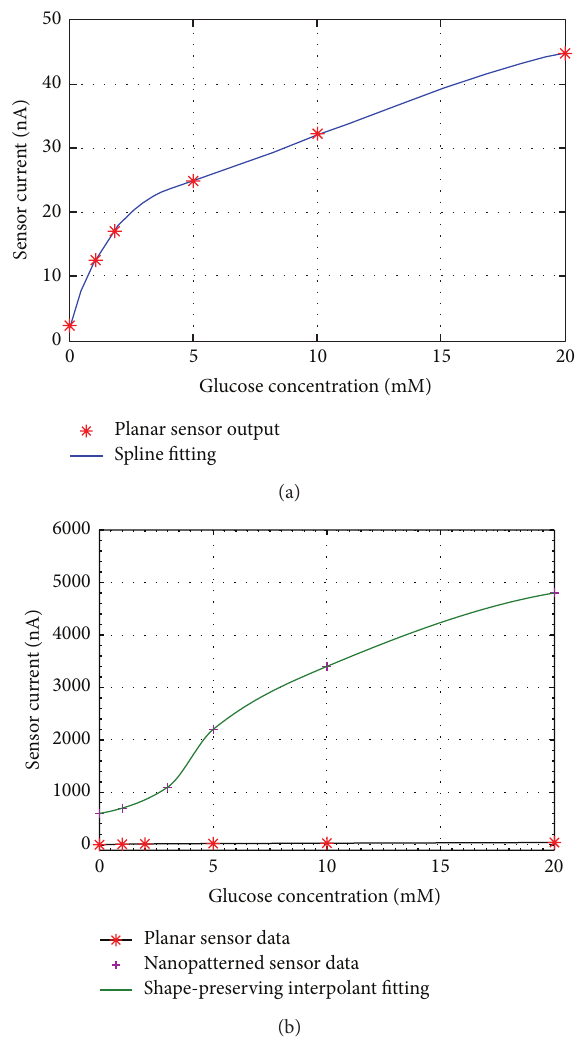
Figure 18: Response curve of glucose sensor. (a) Planar sensor. (b) Patterned